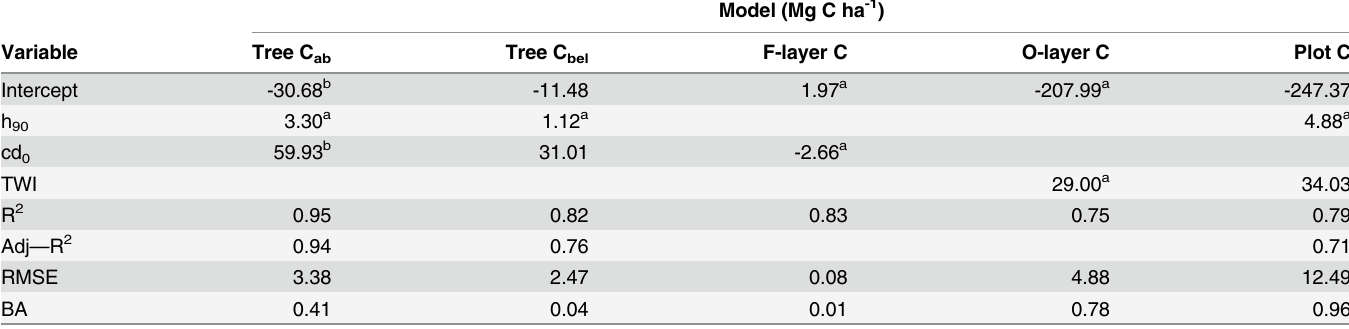
Table 2. Regression